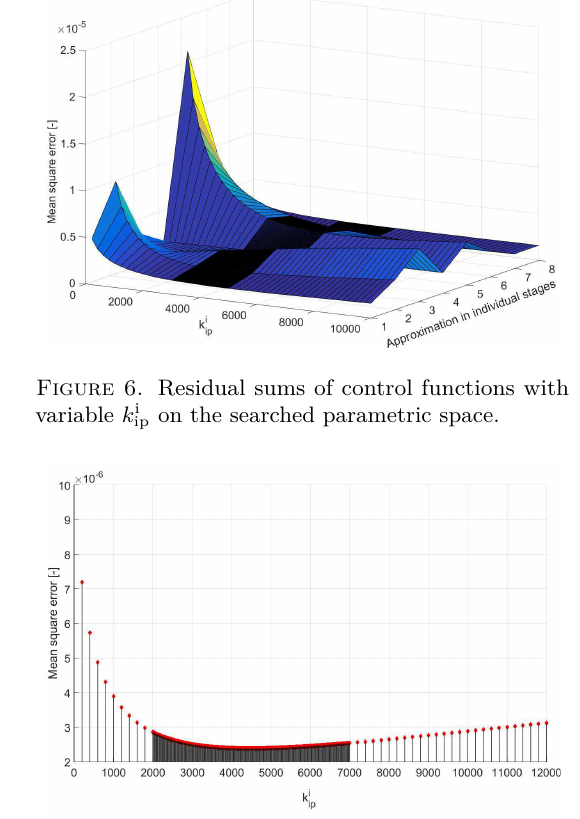
Figure 7. The resulting k minimum of control